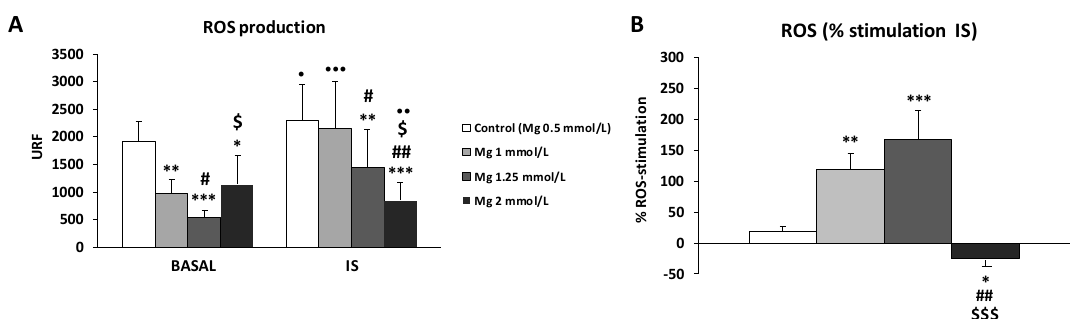
Figure 2. Intracellular reactive oxygen species (ROS) production under basal conditions and in response to indoxyl sulfate (IS) treatment (256 µg/mL) in human THP-1 monocytes cultured in control solution (Hank’s medium) with the standard Mg (0.5 mM; control) or with high Mg concentrations (1, 1.25, and 2 mM). ( A ) ROS levels (URF) and ( B ) percentage (%) increases in ROS production after 180 min of stimulation with IS. Each column represents the mean ± SD of 5–8 independent experiments. * p < 0.05, ** p < 0.01, and *** p < 0.001 vs. the corresponding 0.5 mM Mg (control). # p < 0.05 and ## p < 0.01 vs. the corresponding 1 mM Mg. $ p < 0.05 and $$$ p < 0.001 vs. the corresponding 1.25 mM Mg. • p < 0.05, •• p < 0.01, and ••• p < 0.001 vs. the corresponding basal